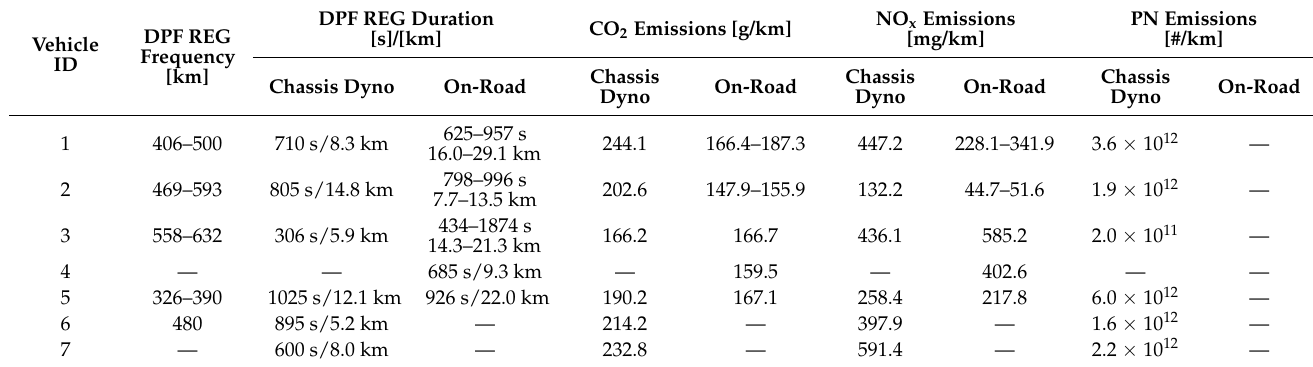
Table A3. Actual CO 2 , NO x and PN emissions throughout the complete test cycle (chassis dyno)/trip (on-road) with DPF regeneration.